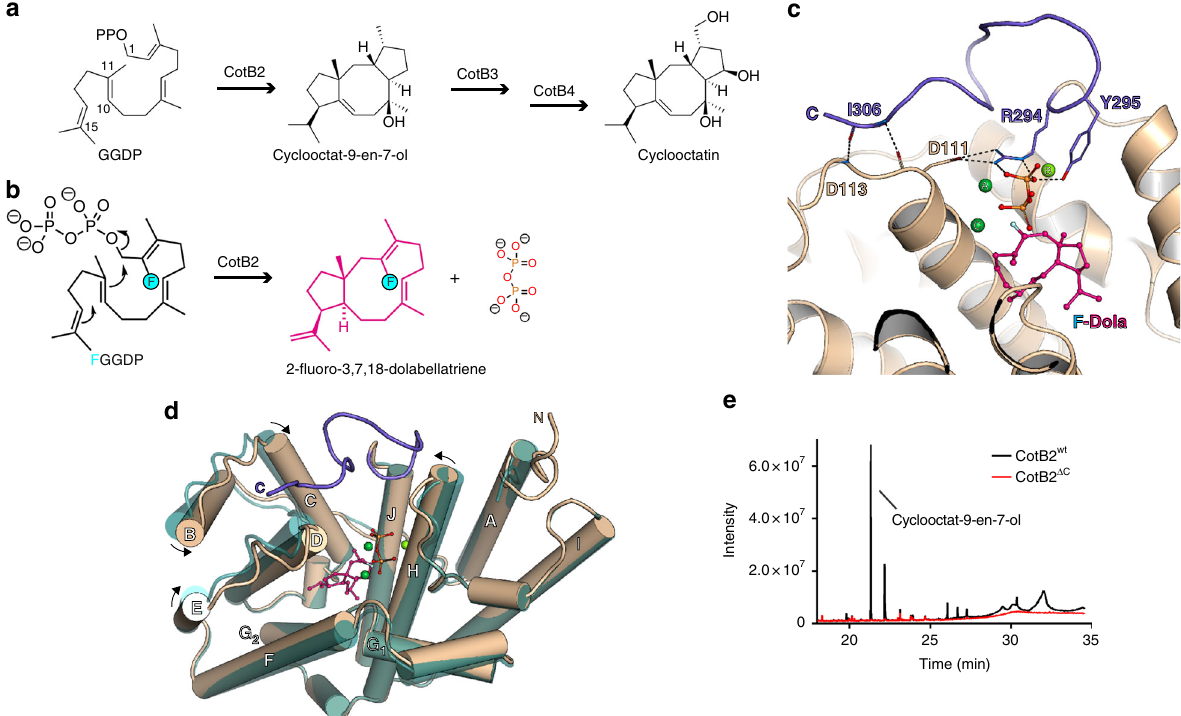
Fig. 1 Enzymatic reaction and the structure of the closed state of CotB2, revealing the importance of its C-terminus. a The linear substrate geranylgeranyl diphosphate (GGDP) is cyclised by CotB2 to a fusicoccane, with a 5-8-5 fused ring system, which is subsequently elaborated to the bioactive compound cyclooctatin by two cytochrome P450 enzymes CotB3 and CotB4, respectively. b 2- fl uorogeranylgeranyl diphosphate (FGGDP) is converted to 2- fl uoro- 3,17,18-dolabellatriene (F-Dola). The fl uorinated position of the substrate-analogue FGGPP is indicated by a light blue circle. c View into the active site of CotB2 wt (cid:129) Mg 2 + 3 (cid:129) F-Dola. CotB2 is shown in cartoon representation coloured in light brown. The bound intermediate is shown in magenta and Mg 2 + -ions are shown in green. Folding of the C-terminus (purple) leads to the formation of several hydrogen bonds (dashed lines), allowing for sensing of the different catalytically important motives. d Structural superposition of CotB2 wt (open), shown in teal, and CotB2 (cid:129) Mg 2 + 3 (cid:129) F-Dola (closed), shown in light brown. e GC/MS spectrum to monitor product formation by CotB2 wt (black) and CotB2 Δ C (red). Deletion of the C-terminus results in an